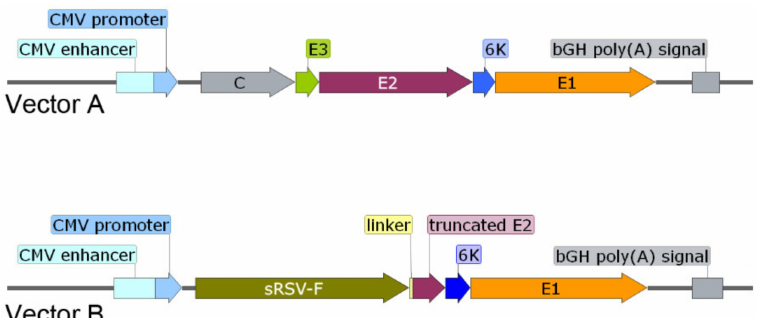
Figure 1. Chikungunya virus DNA vaccine vector constructs. Vector A expresses the CHIKV struc- tural protein open reading frame under the control of a CMV promoter and followed by the bGH poly(A) signal. Vector B encodes a fusion between sRSV-F and the CHIKV E2 glycoprotein and the remaining glycoprotein region under the control of a CMV promoter and followed by the bGH poly(A)